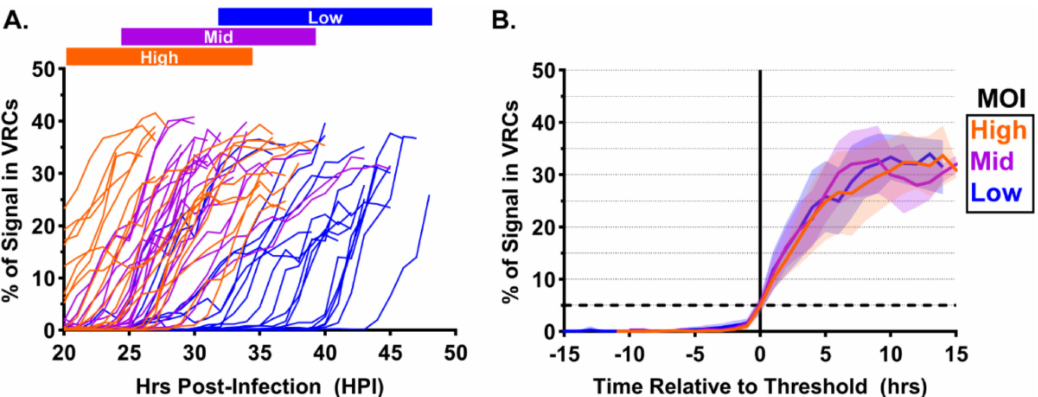
Figure 4. Kinetics of VRC formation depend on multiplicity of infection. GFP-RPA32-expressing cells were infected with MuPyV at one of three multiplicities of infection (MOIs): High (40% infection, orange), Mid (30% infection, violet), or Low (10% infection, blue). Cells were imaged every 12 min from 20–48 HPI and analyzed as described in Figure 3 to yield the proportion of GFP-RPA32 signal associated with VRCs (% of Signal in VRCs) at each time point. ( A ) The “% of Signal in VRCs” shown for individual cells in each condition, plotted as a function of hours post-infection (HPI). Colored boxes above the axes denote the approximate range of VRC formation times for each condition. ( B ) The mean “% of Signal in VRCs” for each condition was calculated after aligning individual cell traces to the frame in which they first exceed 5% of signal in VRCs (horizontal dashed line). Error (Std. Dev.) is denoted by semi-transparent shaded areas. n = 20 cells per